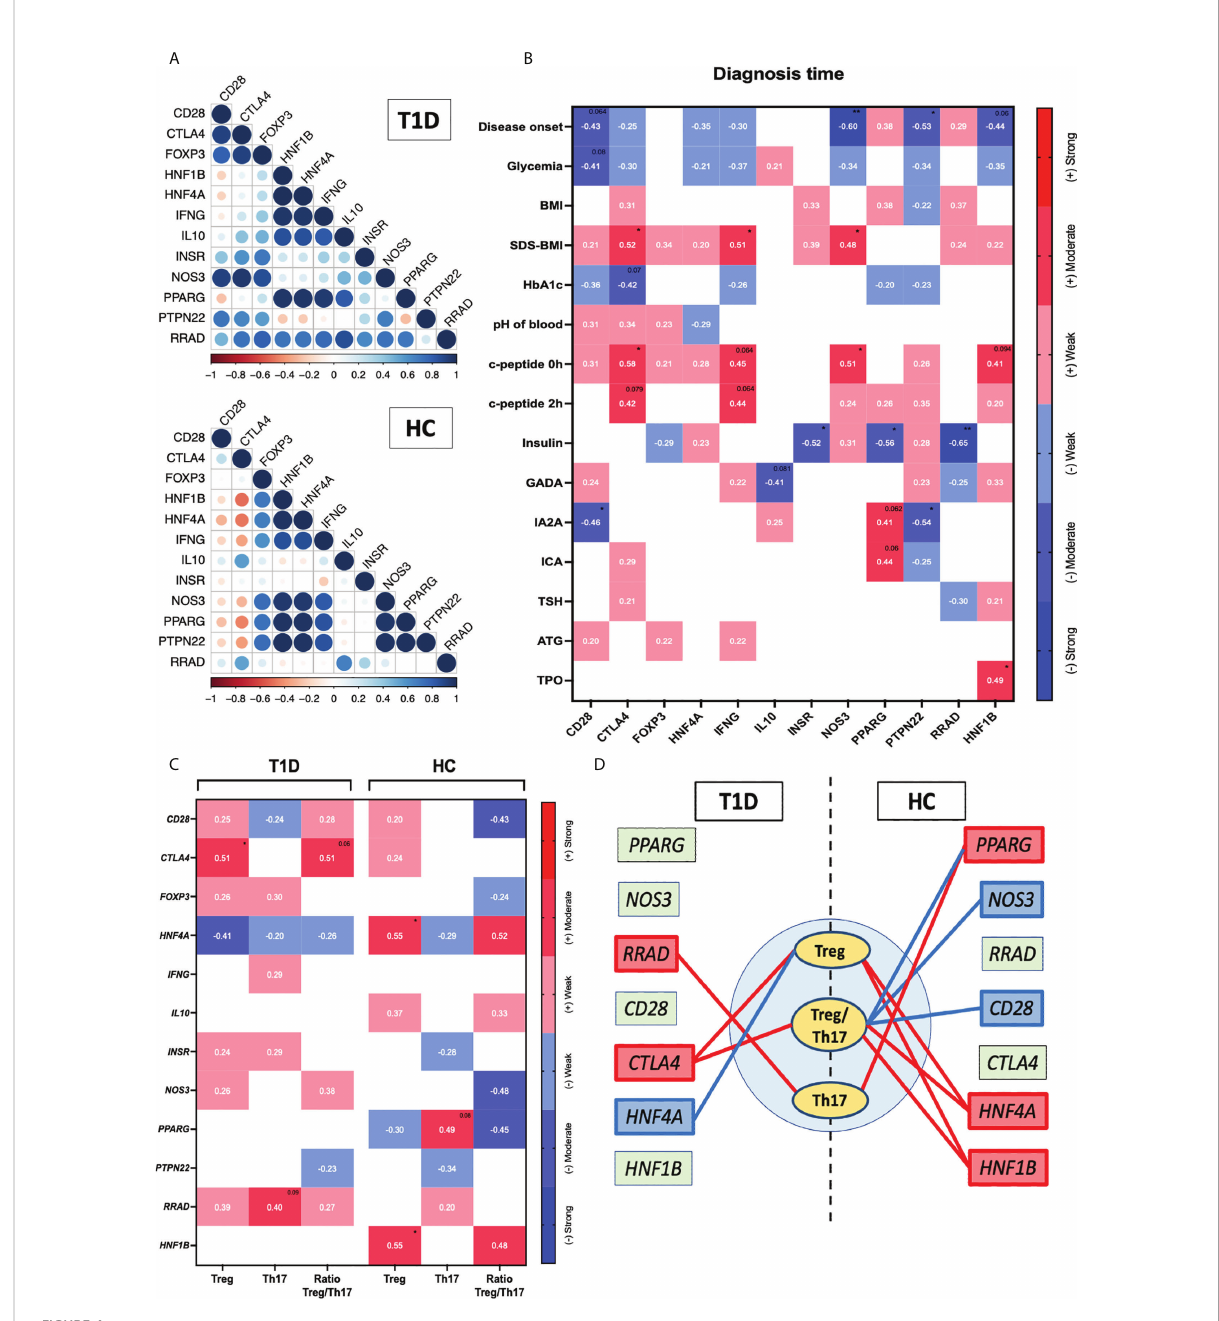
FIGURE 4 Assessment of diabetes-related genes association with the immune cells. The mutual interactions of selected genes in healthy control and T1D group (r values represented by circles diameter) (A) . Correlation of the genes with the laboratory parameters at time of diagnosis (B) . Demonstration of Tregs, Th17 and their ratio relation to the tested genes (C) . Graphical visualization of most essential connections between the immune cell subsets and diabetes-related genes (positive/negative correlations indicated with red/blue color respectively; strength based on r values demonstrated through the lines width) (D) . Heat-maps demonstrate r values and color indicating strength subgroup. The levels of signi fi cant differences were indicated with asterisks or exact p values: * - p < 0.05; ** - p <